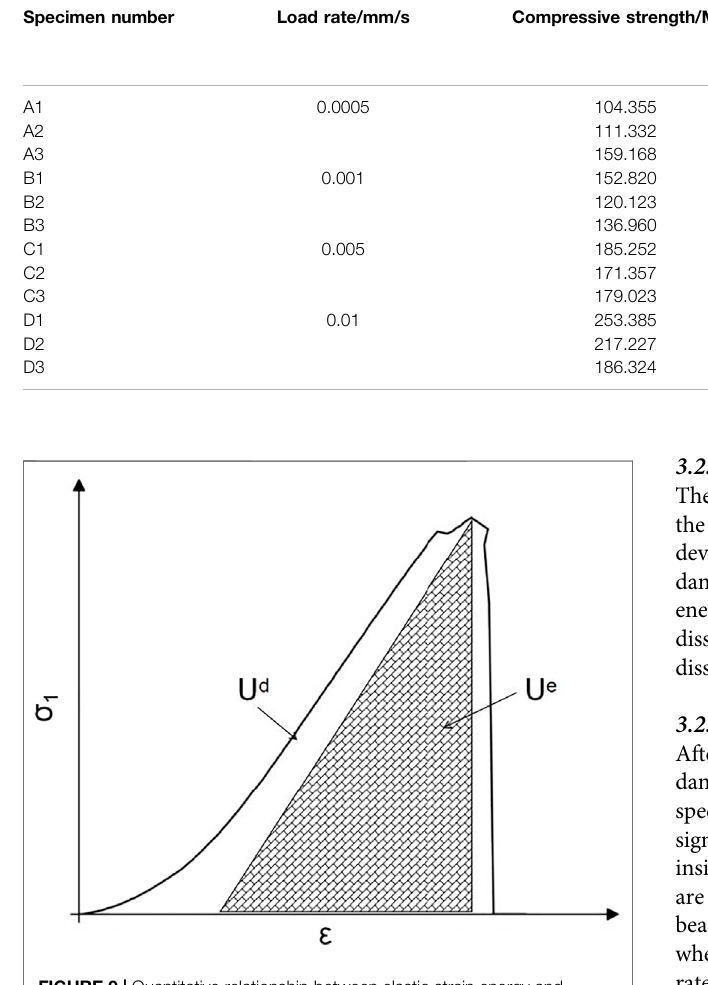
Frontiers in Earth Science |